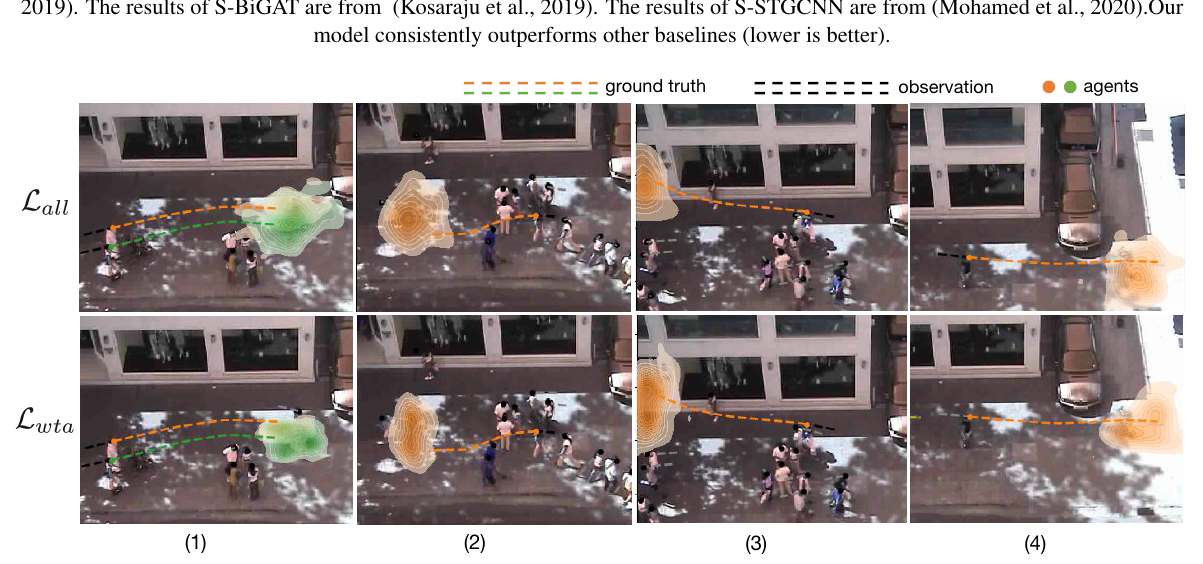
Figure 3. Distribution prediction of final step from two proposed models S − T − L all V 2 and S − T − L wta V 2 in four different sets. L all is model with loss over all modes. L wta is our model with WTA loss. (1)(2) show the distributions in social interactions. (3)(4) show the distributions in multiple